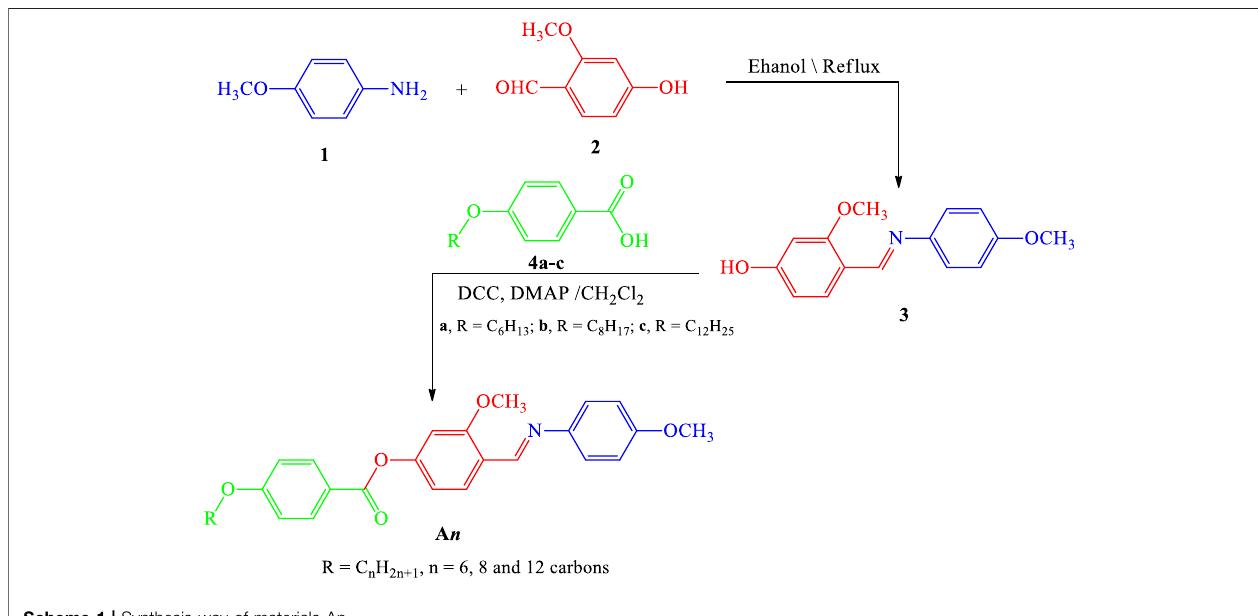
Scheme 1 | Synthesis way of materials